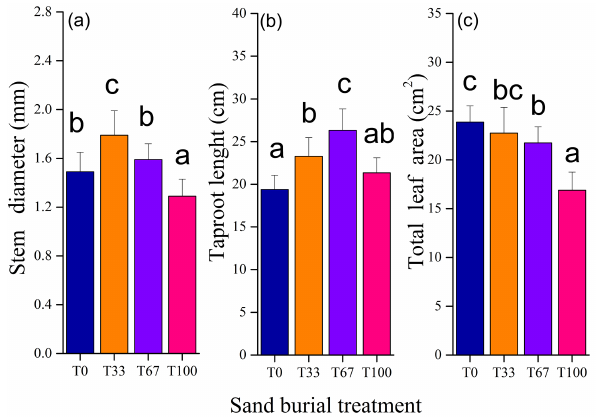
Figure 3. Stem diameter, taproot length, and total leaf area on seedlings of Ulmus pumila var. sabulosa exposed to various sand burial treatments during a 45-day growth period. These treatments included sand burial of seedlings to a depth equivalent to 33 (T33), 67 (T67), or 100% (T100) of the mean seedling height at the ini- tiation of the study. Each histogram is the mean ± 1SE of n = 15. Different letters above histograms among seed burial depths are sig- nificantly different at P